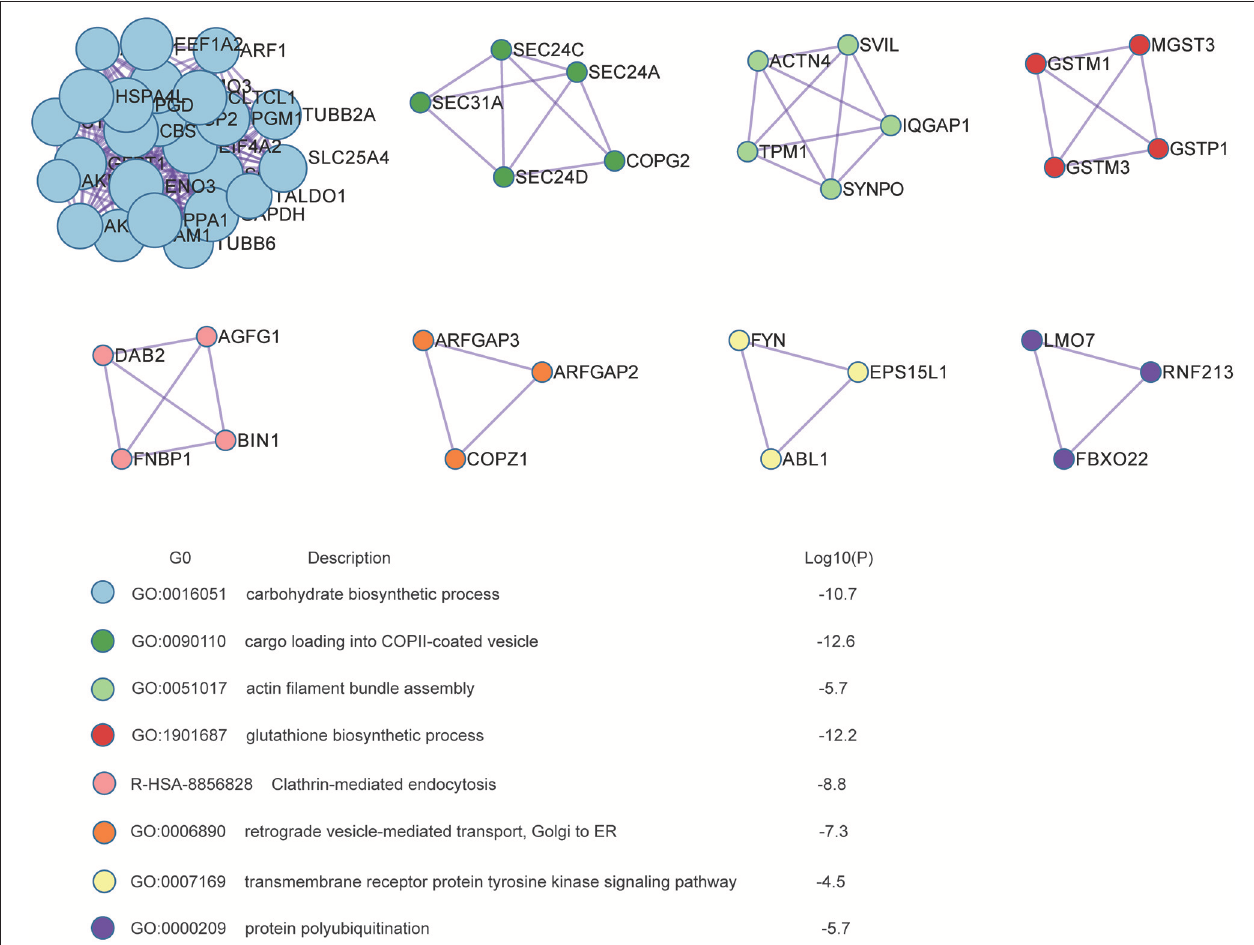
FIGURE 3 | Protein interaction networks based on Protein-Protein interaction enrichment analysis on radioresistance-related 440